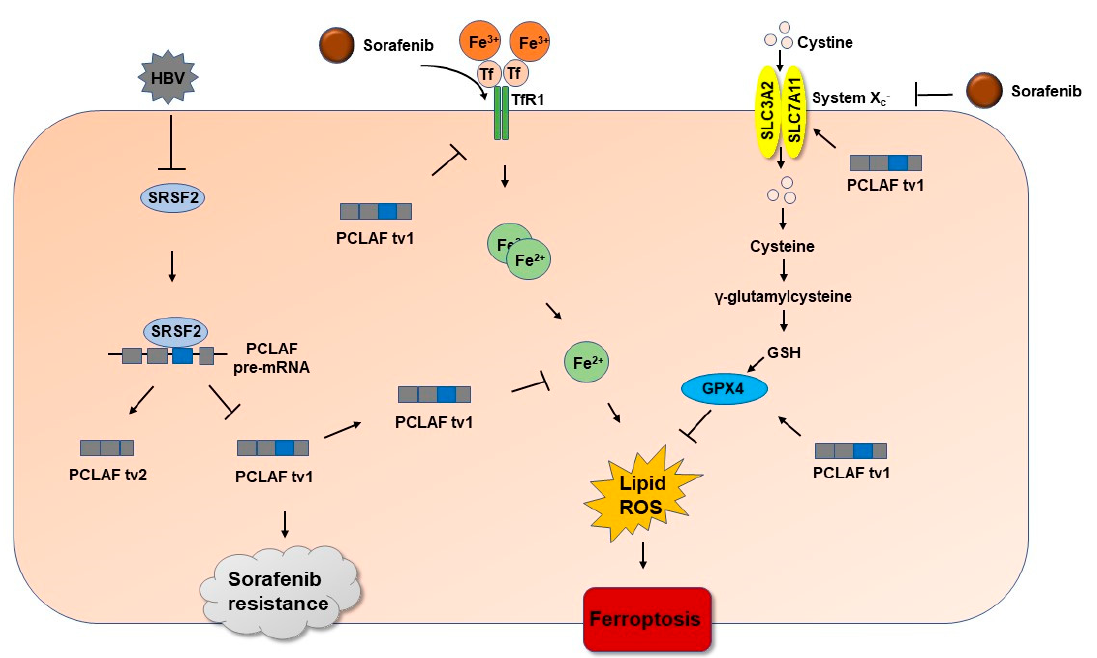
Figure 8. The diagram demonstrates the pathway whereby HBV stimulates PCLAF tv1 splicing by decreasing SRSF2 and contributes to sorafenib resistance in HCC by preventing ferroptosis. HBV promotes PCLAF tv1 splicing by inhibiting SRSF2. Sorafenib therapy induces TfR1-Fe 2+ -induced ferroptosis while suppressing GPX4-suppressed ferroptosis in HCC. HBV inhibits ferroptosis via the SRSF2/PCLAF tv1 pathway, which acts on both the TfR1-Fe 2+ and the GPX4 pathways and hence mediates sorafenib resistance.